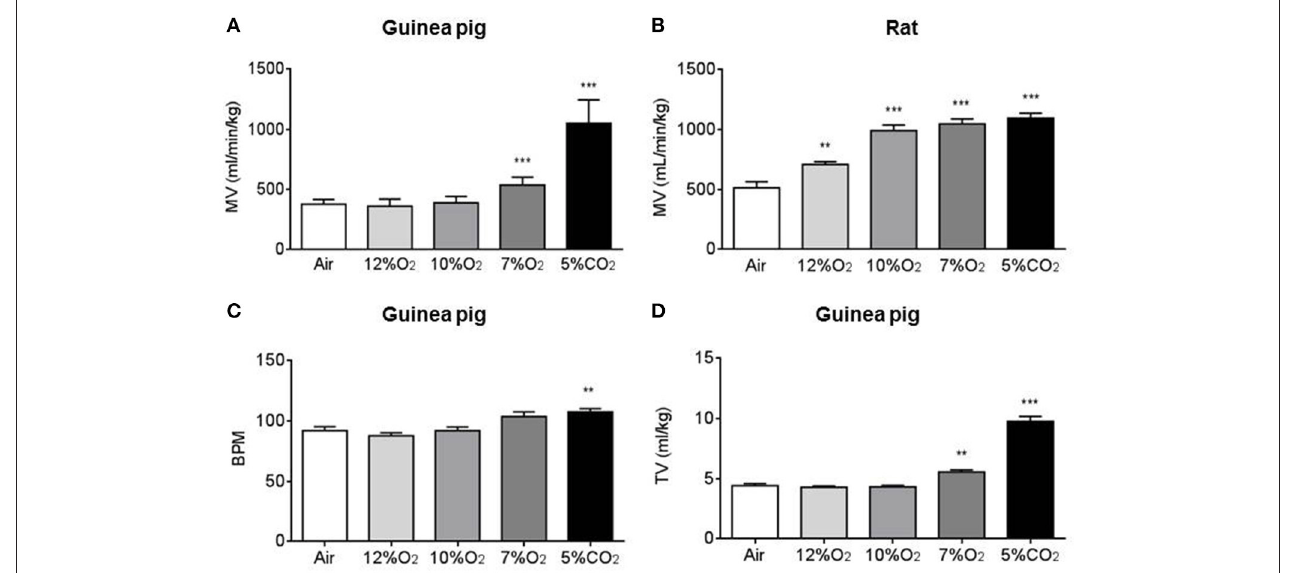
FIGURE 1 | Figure shows minute volume/Kg of weight (MV) from guinea pigs (A) and rats (B) breathing air (21% O 2 ), acute tests of hypoxia with different hypoxic mixtures (12, 10, and 7% O 2 ) and acute test of hypercapnia (5% CO 2 ). In (C,D) are represented the respiratory frequency (breath per min; BPM) and tidal volume (TV) from guinea pigs. Data are mean ± SEM of 16 guinea pigs and 20 rats (3–4 months old). ** p < 0.01 vs. air; *** p < 0.001 vs. air.